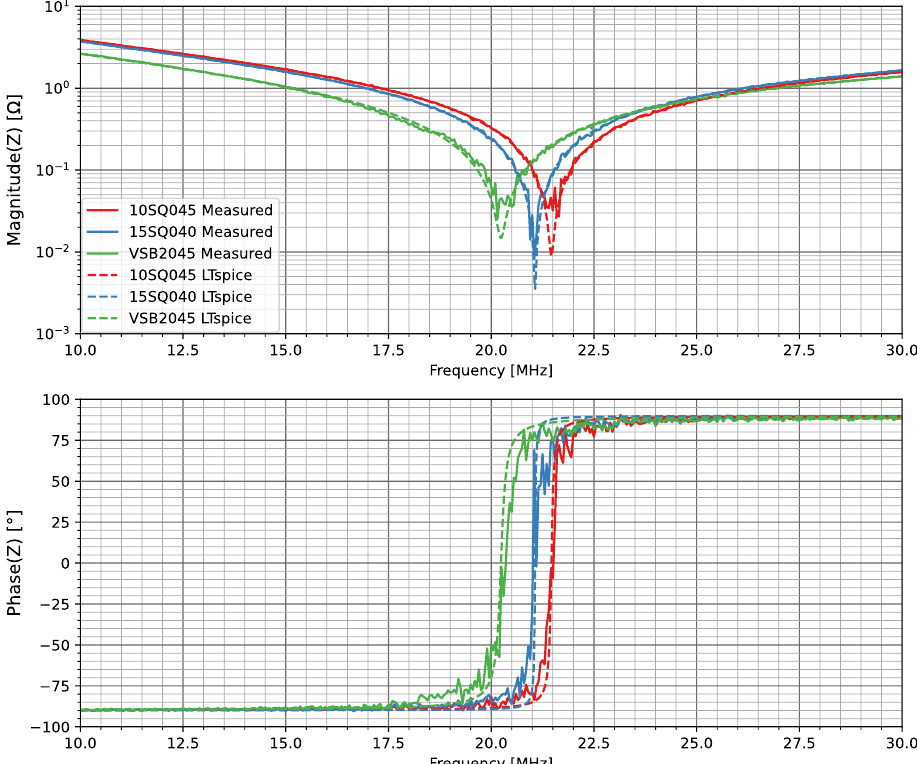
Figure 26. Measured and simulated magnitude and phase plots of the three diodes between 10MHz and